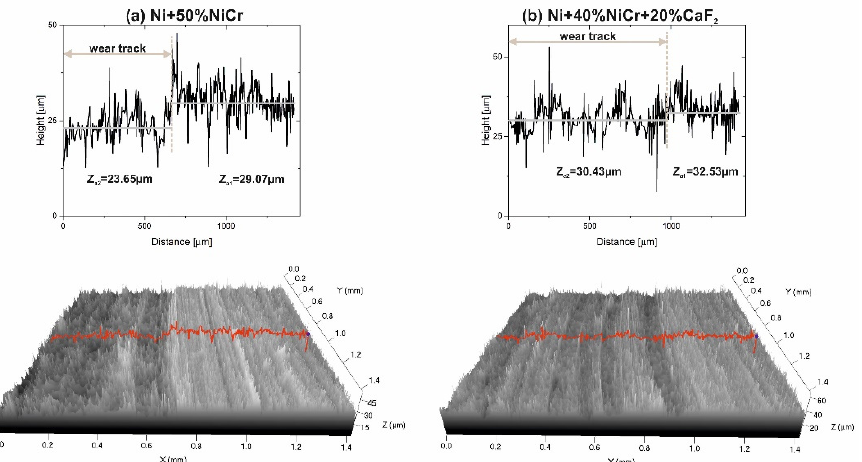
Figure 10. Stereometrics profiles of the counter-samples combined with Ni-50%NiCr(80/20) ( a ) and Ni-40%NiCr(80/20)-20%CaF 2 ( b ), after wear test at room temperature.